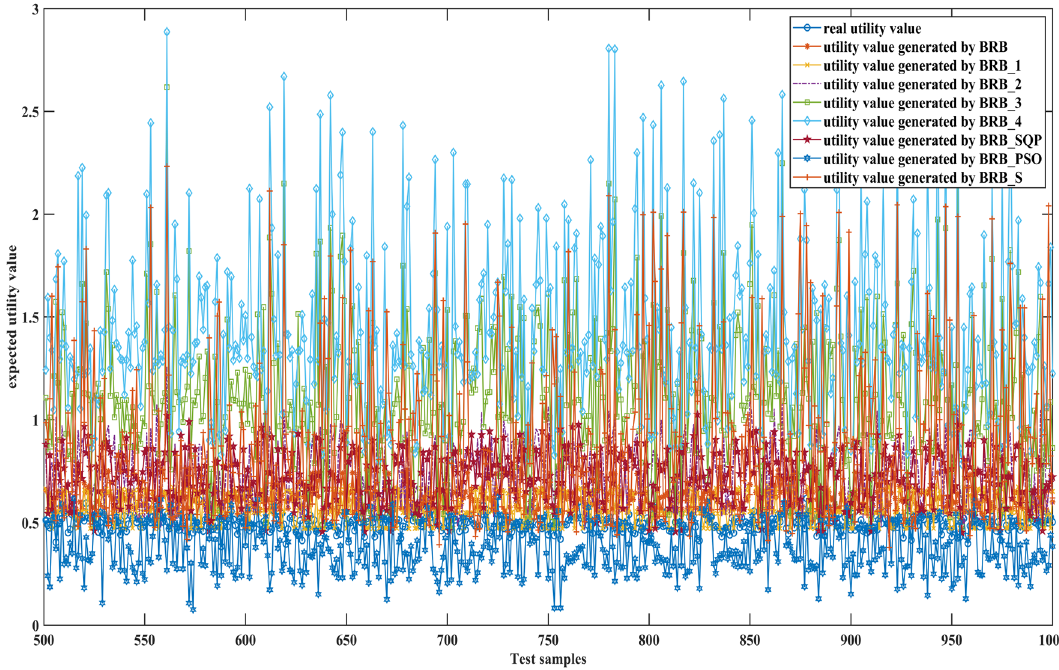
Figure 7. The 501–1000 comparative results generated by different BRBs.